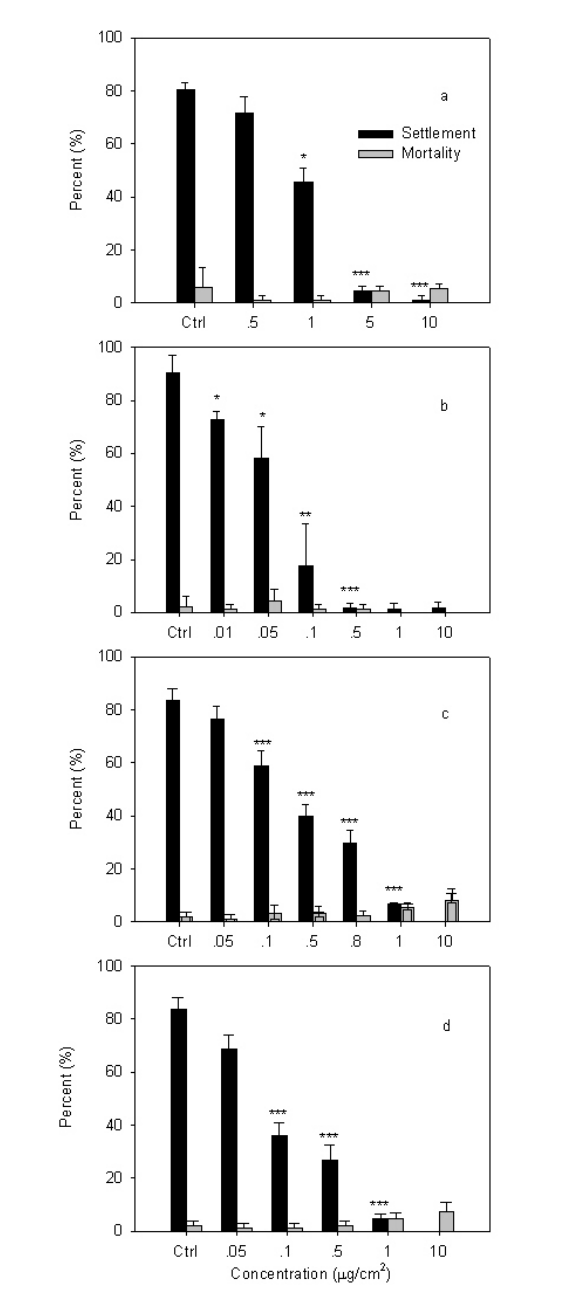
Figure 1. Effects of the compounds on settlement and survival of B. albicostatus